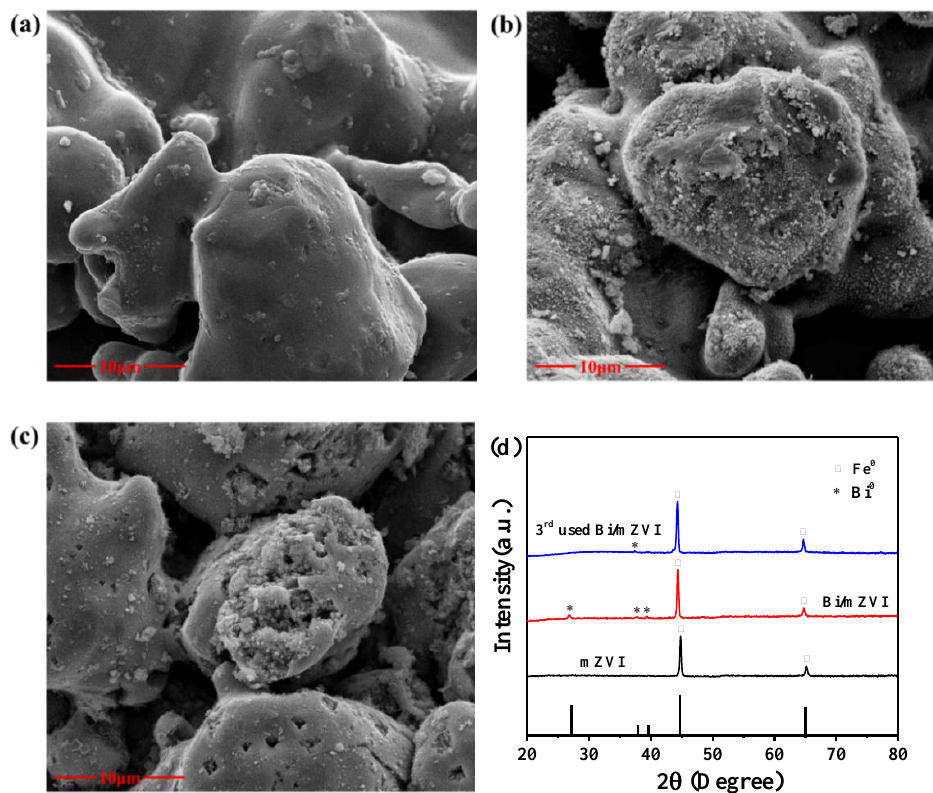
Figure 1. The SEM of ( a ) mZVI, ( b ) Bi/mZVI, and ( c ) 3rd used Bi/mZVI; ( d ) The XRD of different samples.